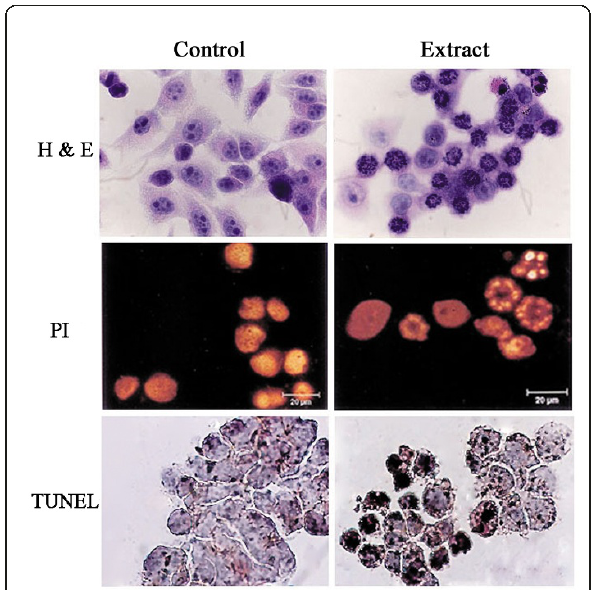
Figure 2 Apoptosis detected by hematoxylin and eosin (H & E), propidium iodide (PI), and TUNEL staining . PC-3M-1E8 cells were treated with 10 μ g/ml TC extract for 24 h. Cells were processed for H & E staining (top panel), PI staining (middle panel) and TUNEL reaction (bottom panel). Apoptotic cells showed condensed and fragmented nuclei and positive TUNEL reaction. The H & E and TUNEL staining were observed by optical microscopy (magnification, × 200). The results of PI analysis were observed by a confocal microscopy. Scale line = 20 μ m.